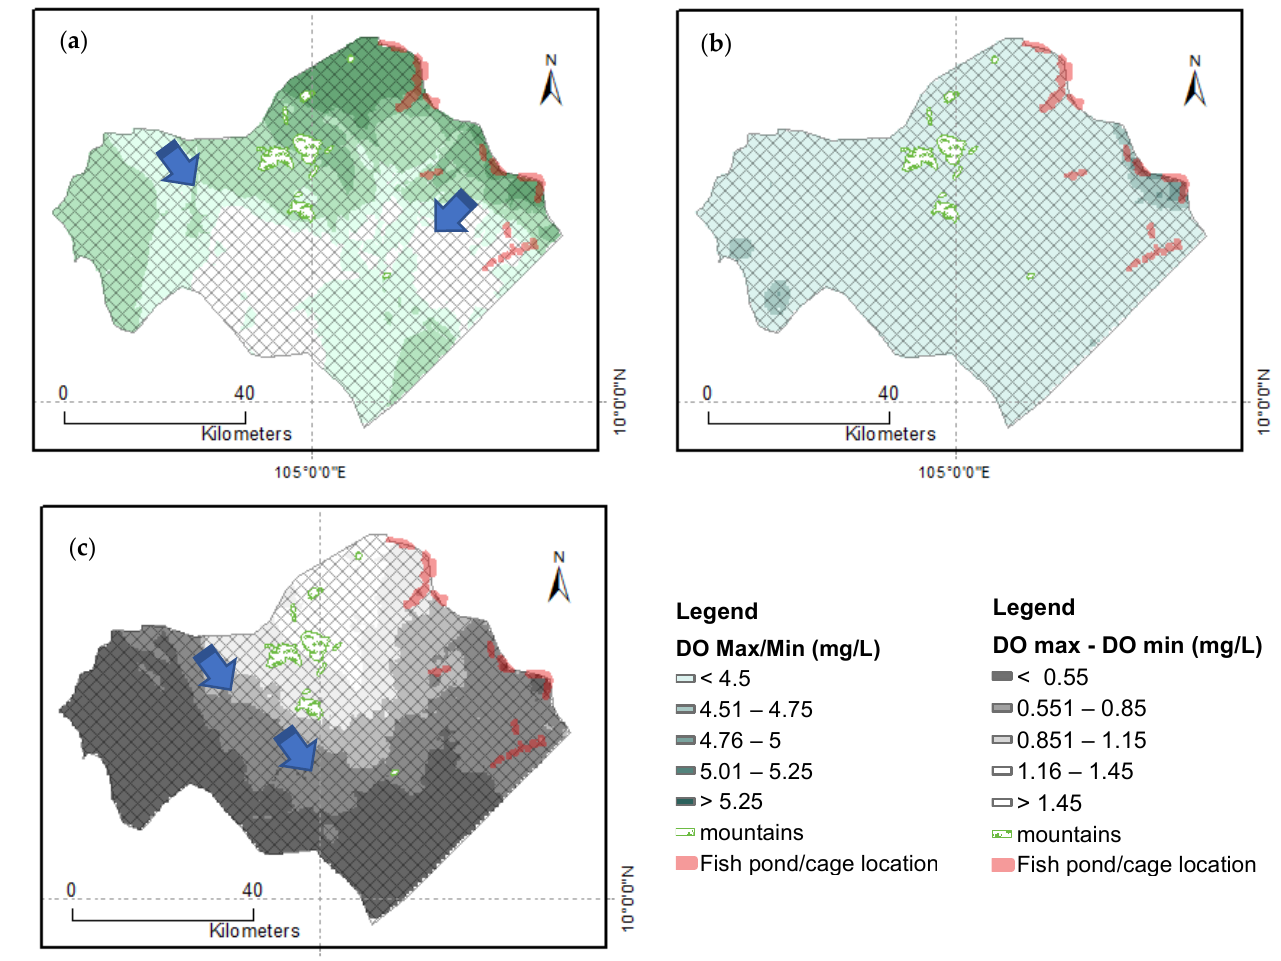
Figure 9. DO concentration in the dry season of 2020. Here, ( a – c ) represent the maximum, minimum and difference between the maximum and minimum DO concentration values, respectively. These arrows show the downward trend of DO concentration (9a and 9b) and the downward trend of DO max–DO min.